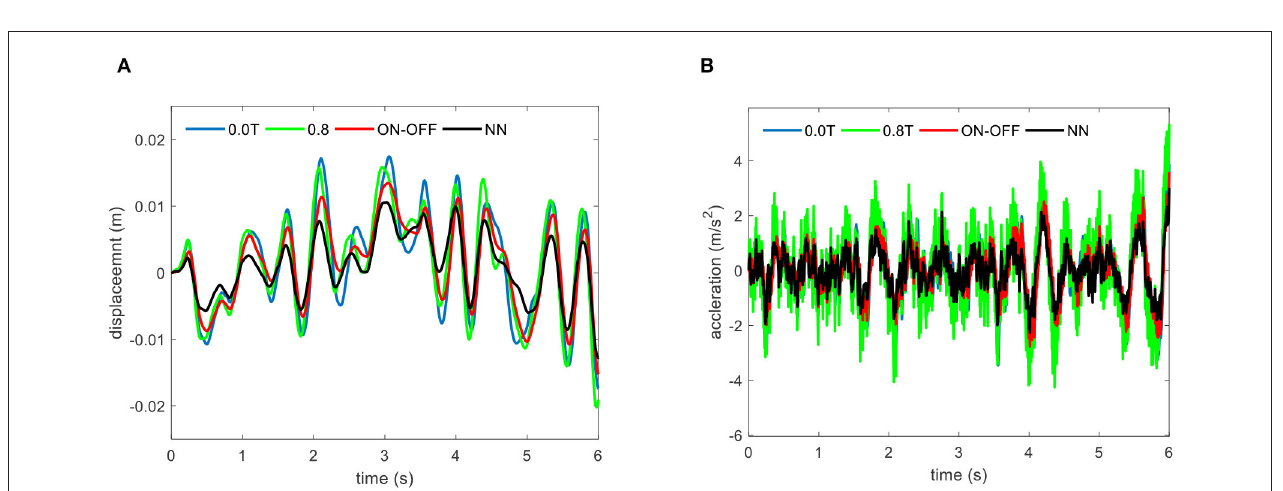
FIGURE 12 | (A) Displacement, and (B) acceleration of the human body ( x d ) for a random excitation case in the presence of various